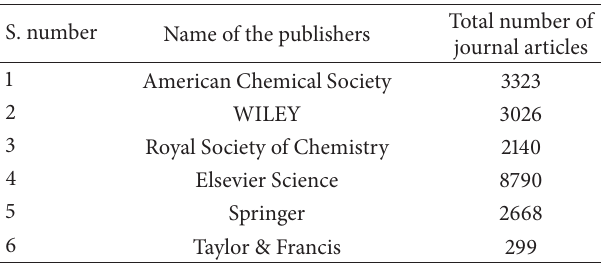
Table 1: Publication scenario of synthesis of silver nanoparticles under standard publishers (1980–2014).